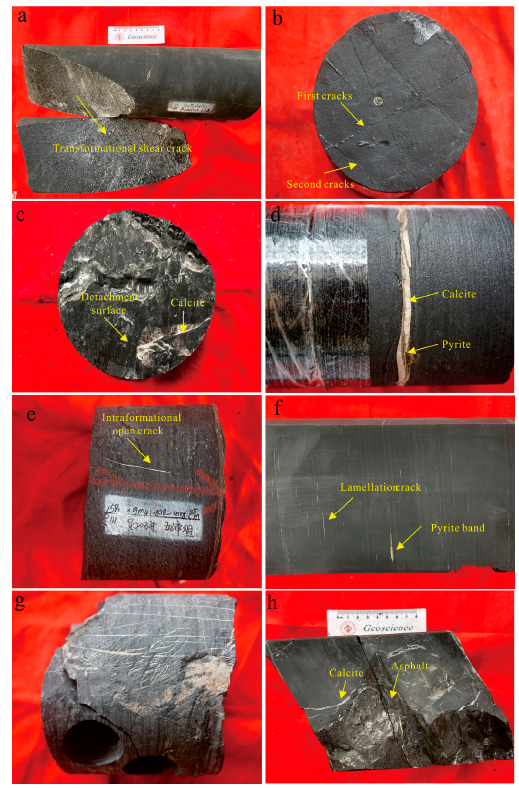
Figure 8. The characteristics of the natural crack development in the Luzhou area. ( a ) L2: 3724.18 m, transformational shear crack; ( b ) L5: 3461.67 m, the intersection of two ‐ stage cracks; ( c ) L5: 3395.87 m, bed ‐ parallel shear crack. There is a mirror slide on the crack surface and there are obvious scratches; ( d ) Y2: 4146.83 m, bed ‐ parallel shear crack. Note the fibrous calcite and pyrite filling; ( e ) Z1: 4108.85 m, intraformational open crack. Cracks are confined between two pyrite layers; ( f ) L3: 4036.53 m, lamellation crack, silicon and calcite filling; ( g ) L4: 4053.18 m, shrinkage crack, calcite fillings; ( h ) L2: 3755.6 m, abnormal high ‐ pressure crack. The crack shape is irregular, there is a high ‐ angle development, crack face asphalt, and calcite filling.